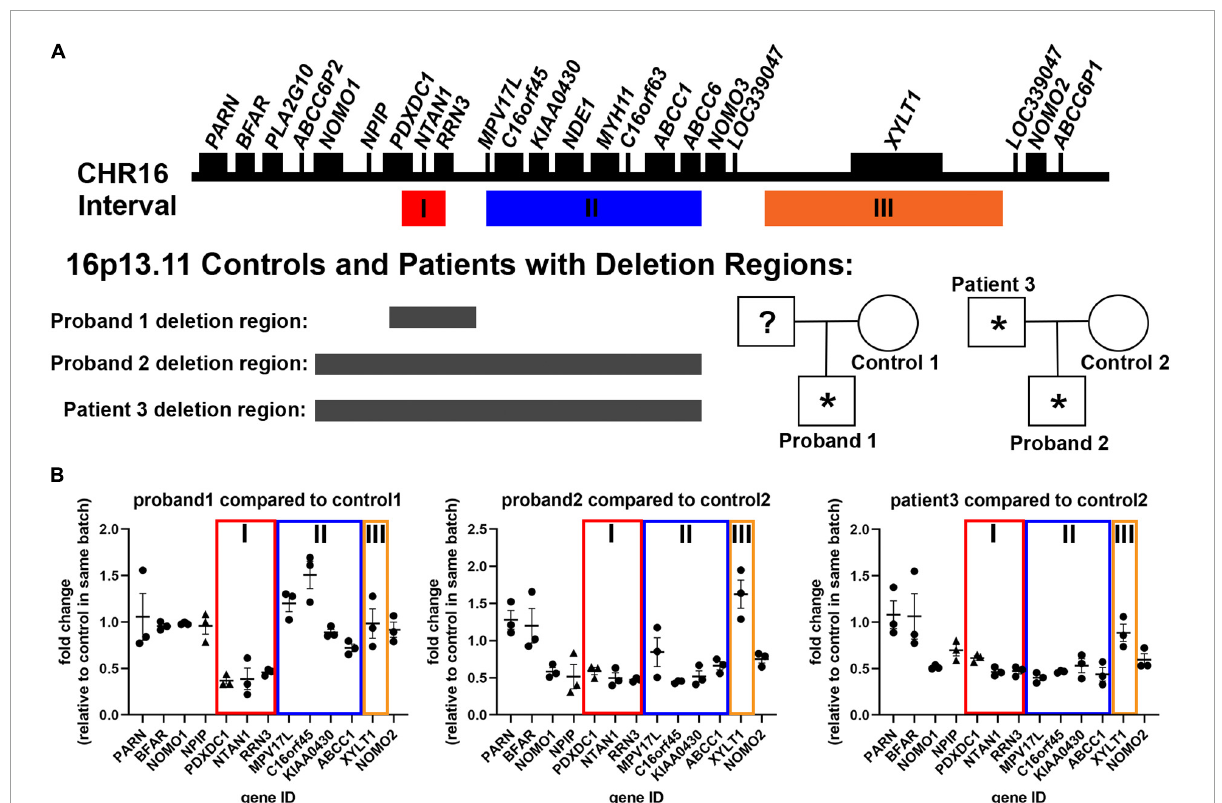
FIGURE1 Description of patient samples recruited to study 16p13.11 deletion. (A) Representation of genes present in the 16p13.11 region, including intervals I, II, and III, and designation for inheritance pedigree and deletion regions found in probands 1 and 2 and patient 3. (B) AmpliSeq (circles) and qPCR (triangles) results from day 14 iPSC-derived cortical neurons showing changes in gene expression levels of genes in the 16p13.11 region in all three patients. Data are shown as ± SEM, n = 3